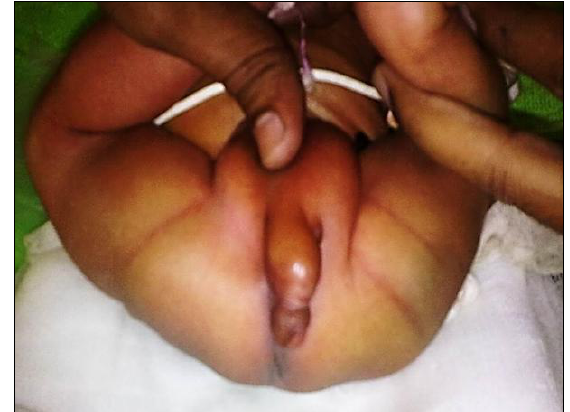
Figure 1: Image showing a well-developed phallus in between the scrotum and anal